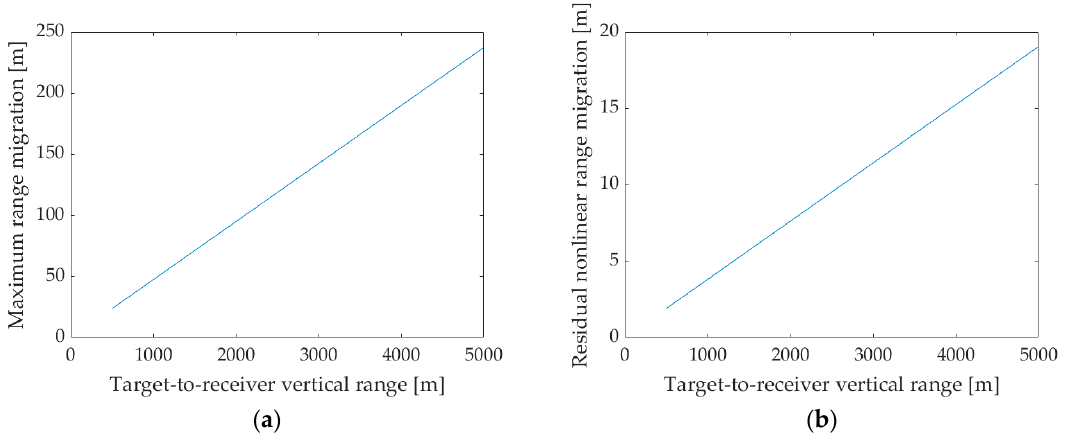
Figure 6. Maximum range cell migration (RCM) for the target at the imaging scene center with satellite elevation angle = 45°, local azimuth angle = 45°, and radar antenna beam angle = 10°: ( a ) is the maximum RCM before range walk correction, and ( b ) is the residual maximum nonlinear range migration after range walk correction.